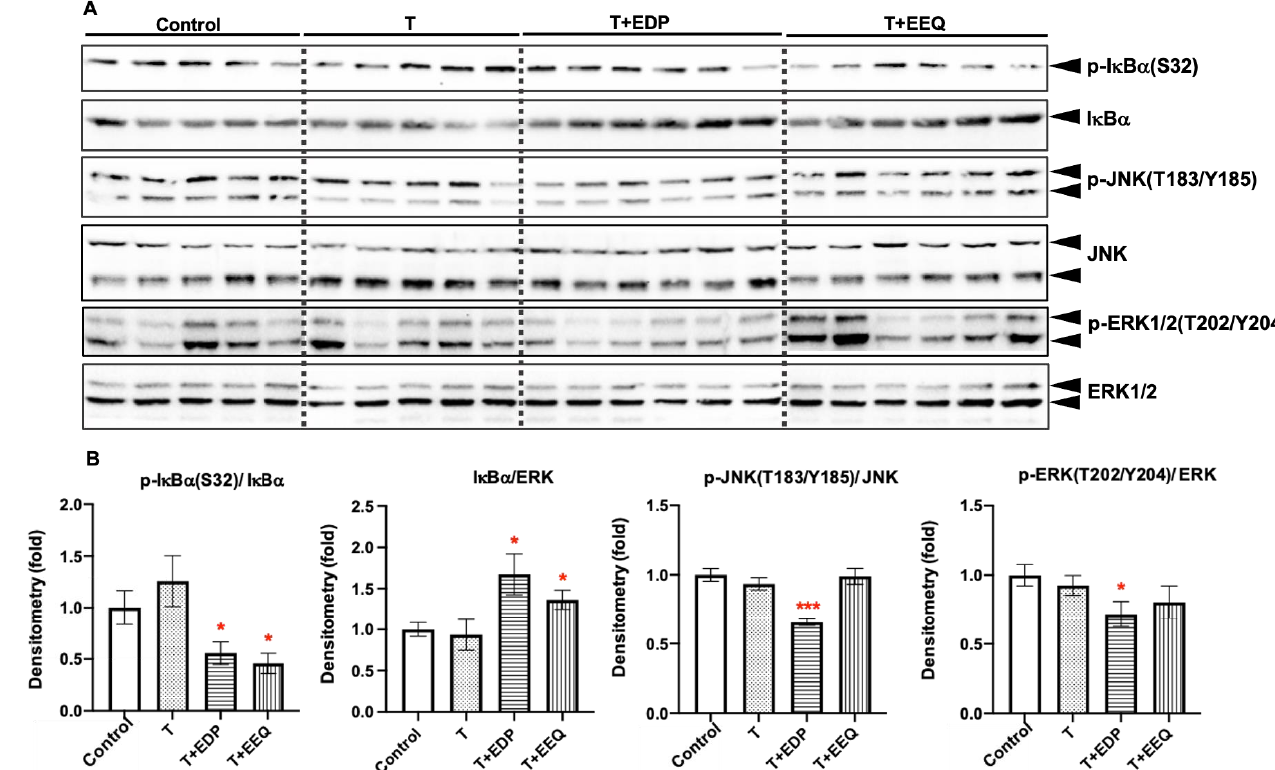
Figure 6. 17,18-EEQ or 19,20-EDP combined with t -TUCB delivered via mini osmotic pump regulated the activation of inflammatory pathways in the iBAT of diet-induced obesity. Protein expression of p-I κ B α (S32), I κ B α , p-JNK(T183/Y185), JNK, p-ERK1/2(T202/Y204), and ERK1/2 in the iBAT of mice in the control, T, T + EDP, and T + EEQ groups ( A ), and their densitometry ( B ) are shown. Bar graphs show the normalized densitometry for p-I κ B α (S32)/I κ B α , I κ B α , p- JNK(T183/Y185)/JNK, and p-ERK(T202/Y204)/ERK. Data = the mean ± SEM ( n = 5–6). * and *** = p < 0.05 and p < 0.001 compared to the control, respectively.